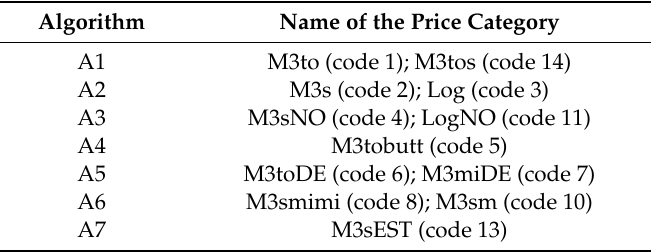
Table 1. Seven algorithms (A1–A7) for log volume estimations according to StanForD. Price categories were merged to algorithms based on the log volume estimating